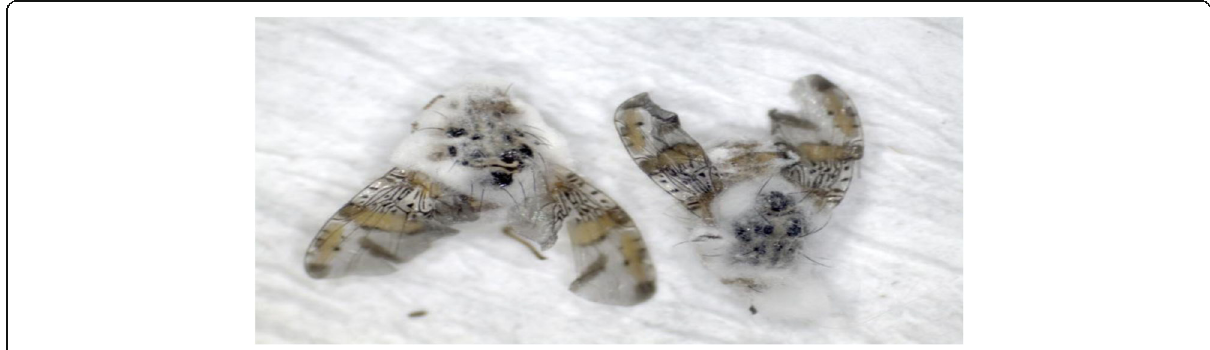
Fig. 5 Infection symptoms on adults of Ceratitis capitata induced by Beauvaria bassiana isolate BMAUM M6-4